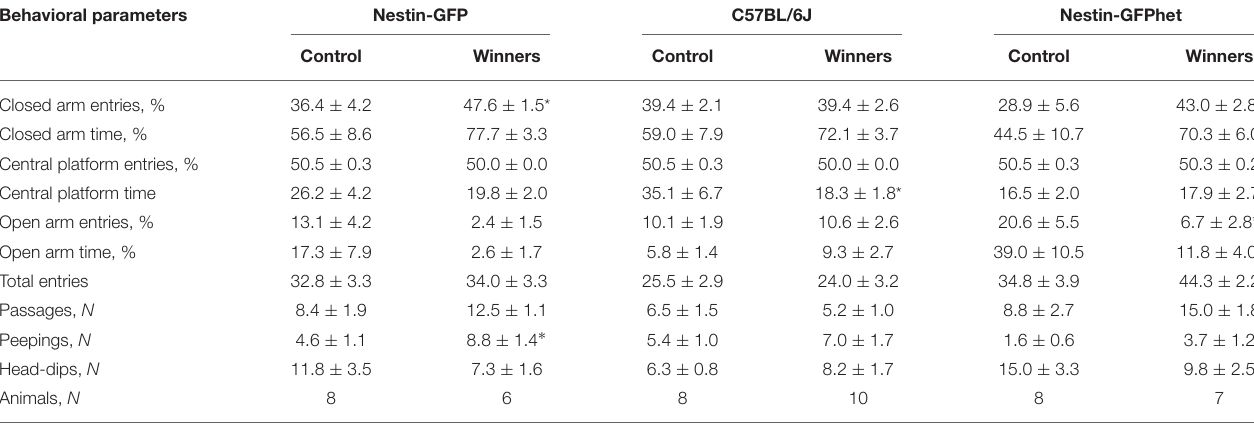
TABLE 2 | Behavior in the elevated plus-maze test of the Nestin-GFP, C57BL/6J, and Nestin-GFPhet winners after 21 days of agonistic interactions. Behavioral parameters